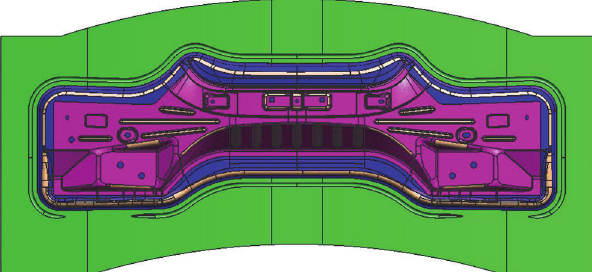
Figure 2: Drawing die model (die).